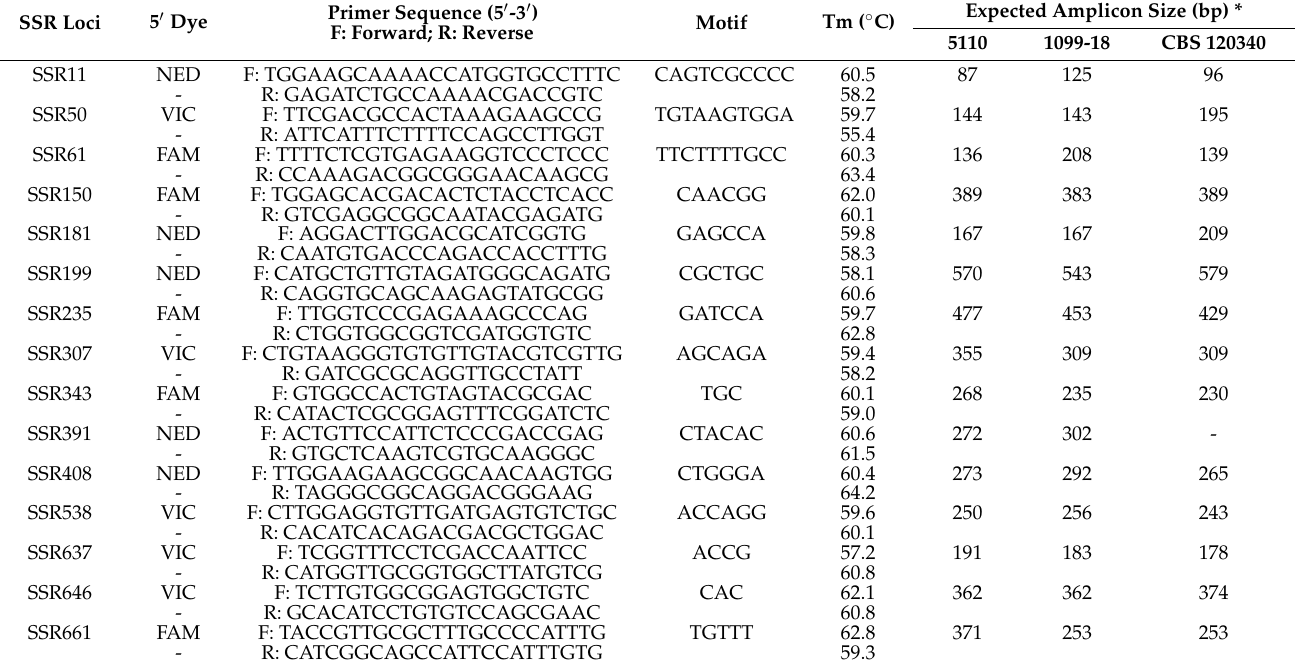
Table 2. Primer sequences, repeat motifs, primer annealing temperature (Tm) for each SSR